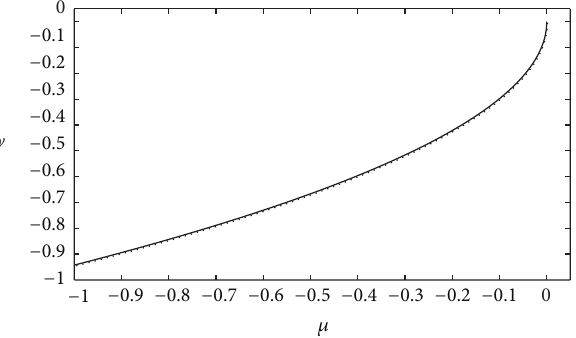
Figure3:Comparisonbetweenthecurveofnonhyperbolicperiodic of (139): the dotted curve was obtained numerically orbits 𝐶 NH with the software MATCONT and the continuous curve from the representation